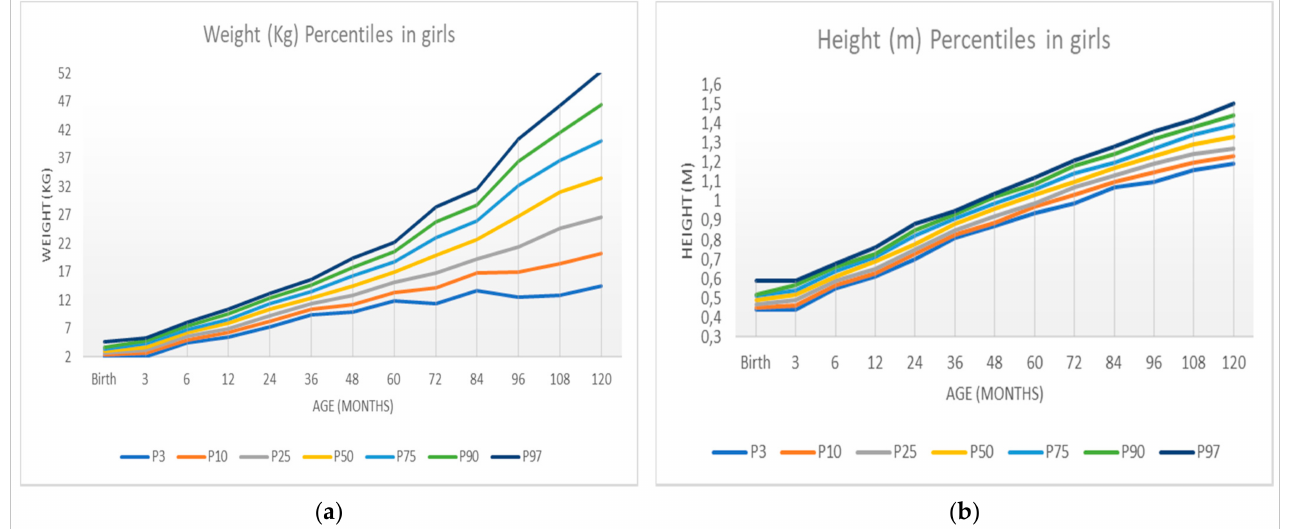
Figure 5. Weight and height percentiles in girls according to age: ( a ) weight percentiles; ( b ) height percentiles.